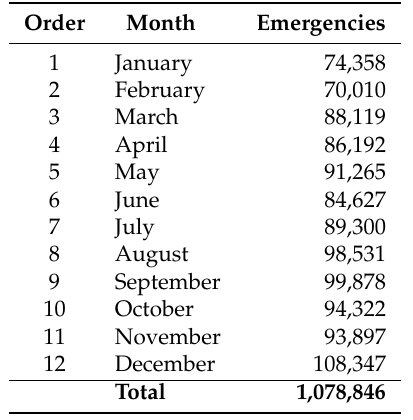
Table 1. Emergencies attended by the Public Safety Answering Point (PSAP) of Quito in 2014.